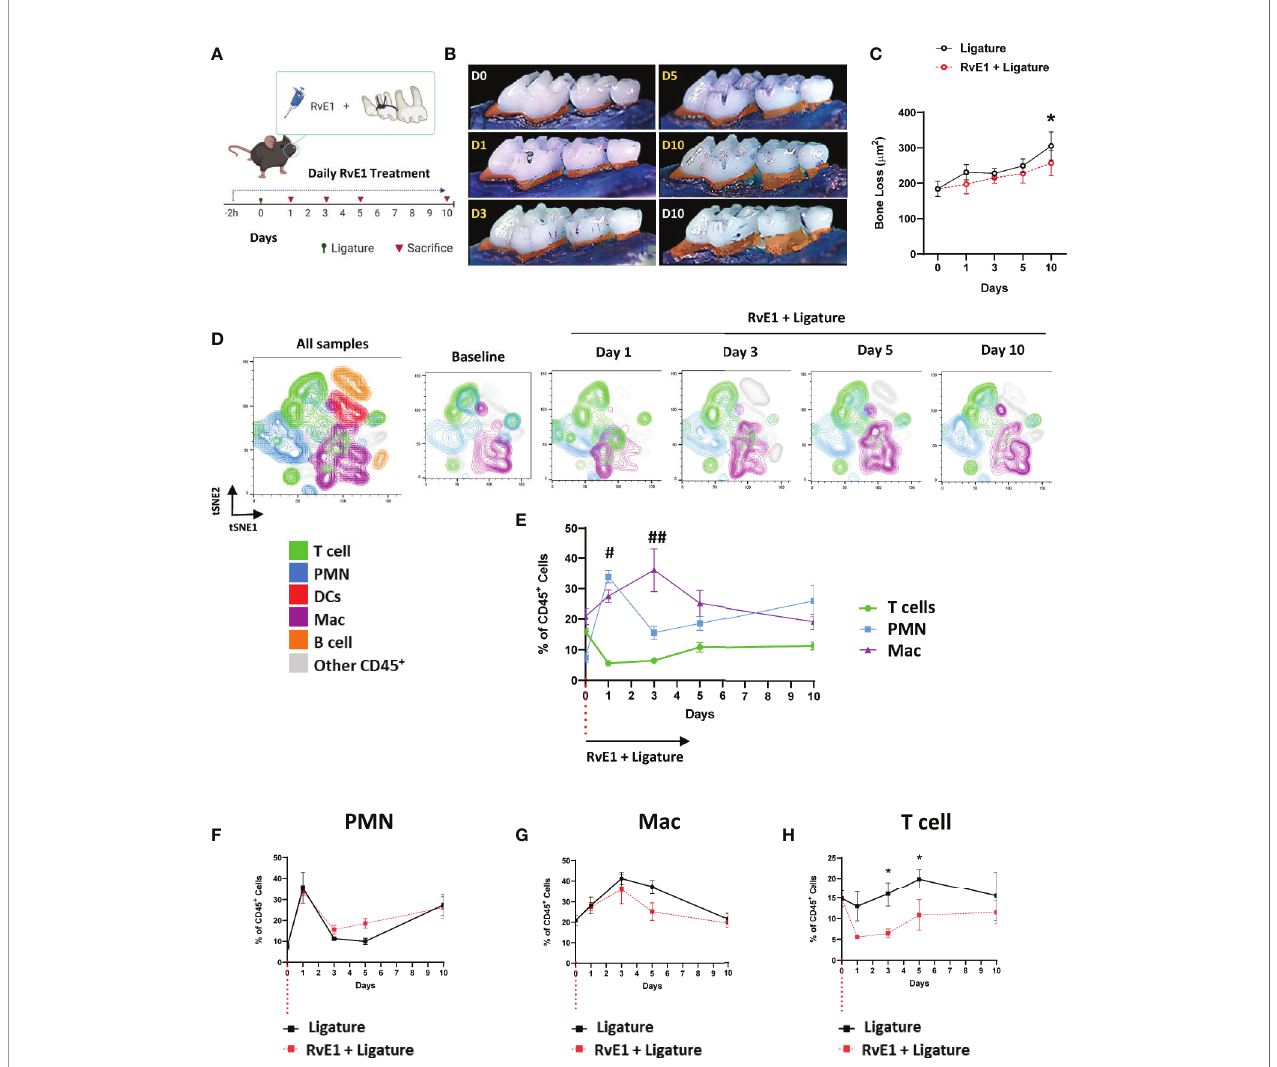
FIGURE 2 | Temporal-dependent changes of the gingival immune-in fi ltrate in experimental periodontitis due to early RvE1 administration. (A) Experimental design. (B) Representative palatal views of maxillary molars from animals sacri fi ced at days 1, 3, 5, 10 after ligature application with or without RvE1 treatment (D1-D10 in yellow), baseline (D0) and ligature without treatment at day 10 (D10 white) as references. Bone loss area is highlighted in orange. (C) Bone loss in RvE1-treated and non-treated animals (n=5). (D) Identi fi cation of neutrophils (PMN, CD45 + Ly6G + ), macrophages (Mac, CD45 + CD11b + CD64 + ), and T cell (CD45 + CD3 + ) subsets in tSNE graphs of concatenated data (n = 4 animals per group) within CD45 + gingival cells. (E) Comparison of the frequencies of PMN, T cells, and macrophages within CD45 + gingival cells (F – H) Comparison of the frequency of each cell subtype within CD45 + gingival cells over time in animals with or without RvE1 treatment. # P < 0.05 T cells vs PMN and Mac; ## P < 0.01 T cells vs PMN and Mac; *P <